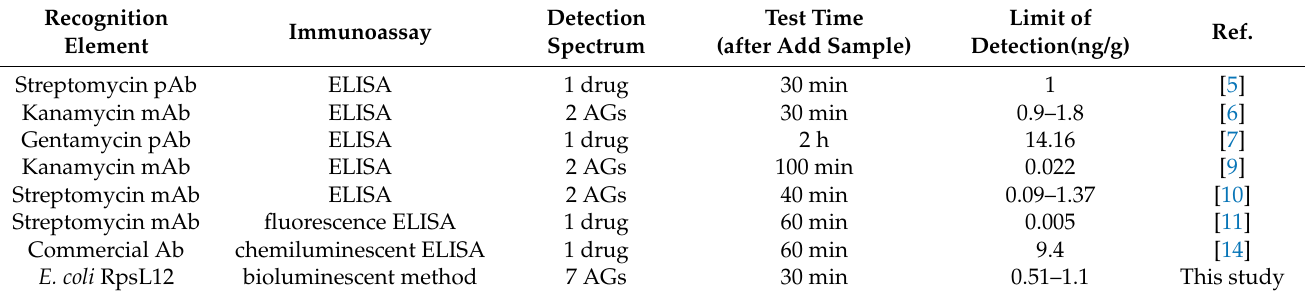
Table 3. The main results of previous enzyme-linked immunosorbent assays (ELISAs) for